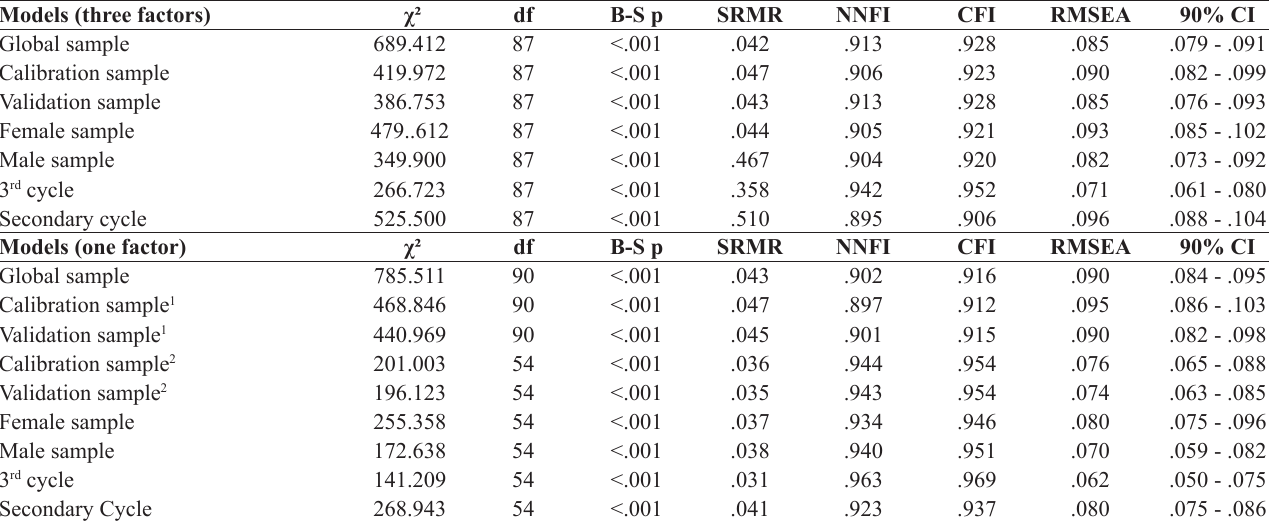
Table 2. Fit indices of the three factor and one factor measurement models of PESSp Models (three